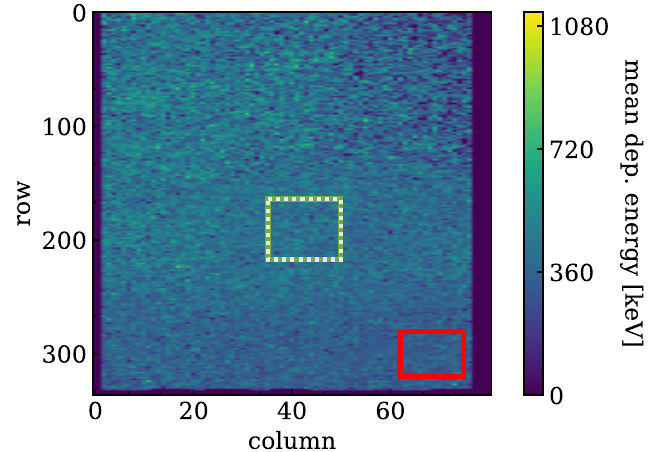
Figure 4. Mapofmeandepositedenergyforeverypixelmeasuredwithabeamenergyof E phantom ≈ 65.4MeV. The colored frames indicate two example regions of interest, highlighting the variation of the de- posited energy across the regions of the staircase phantom.